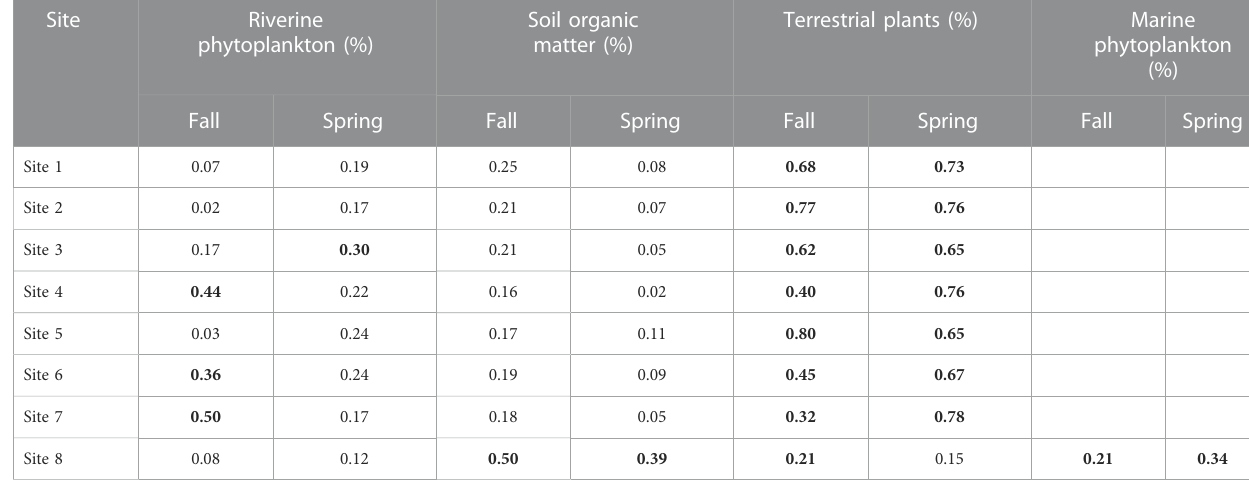
TABLE 4 Mean of the MixSIAR model-estimated proportions of potential source contributions to the particulate organic matter during both